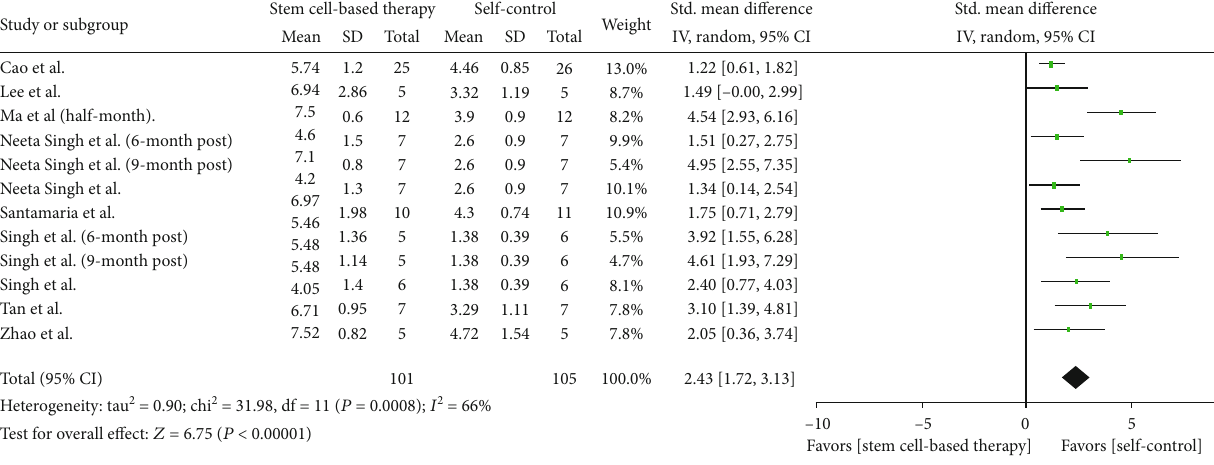
Figure 4: Endometrial thickness